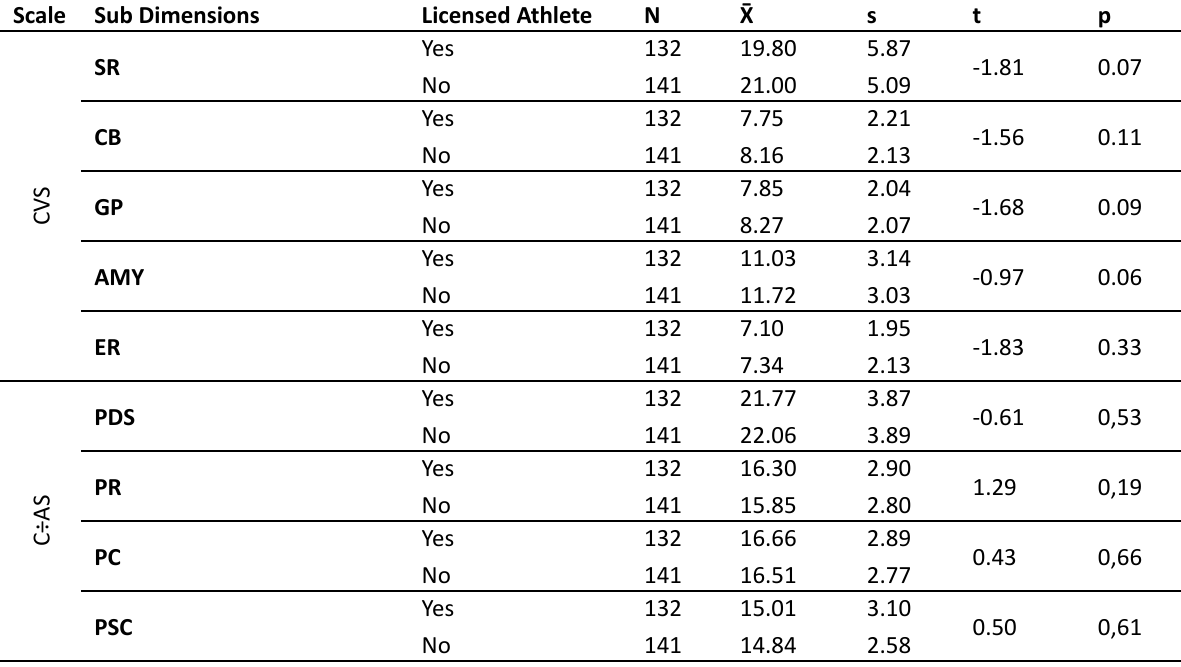
Table 4. CVS and CAS sub-dimension t-test results of the participants in terms of the type of Licensed Athlete Scale Sub